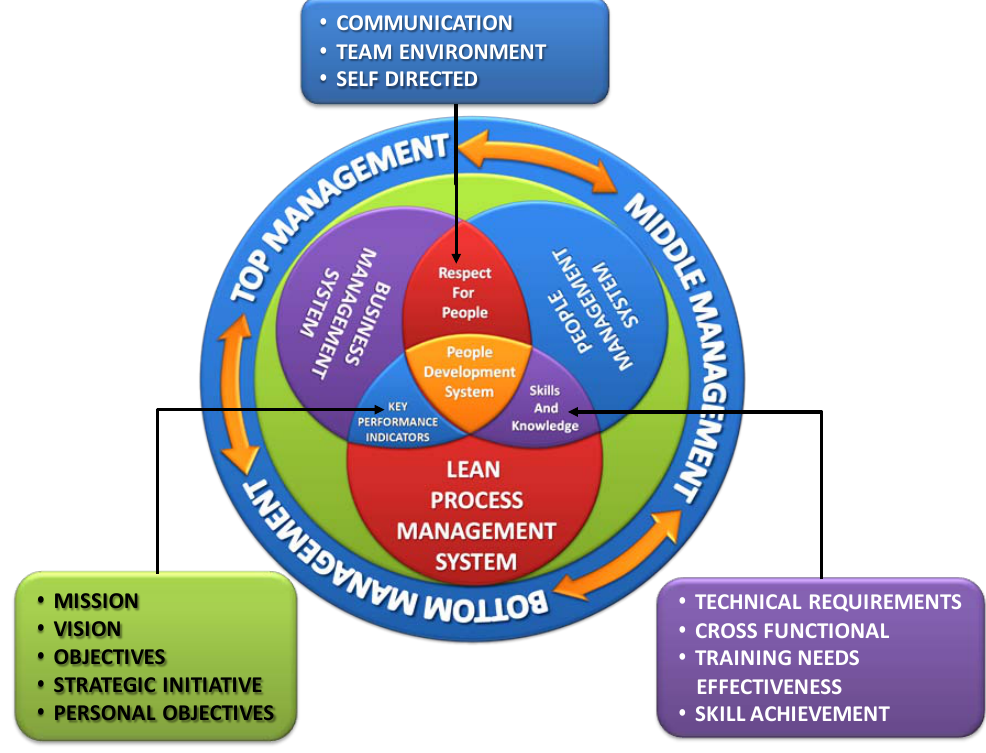
Figure 1. “Framework for enhancing the problem solving capabilities of the employees”. Source: Puvanasvaran et al.